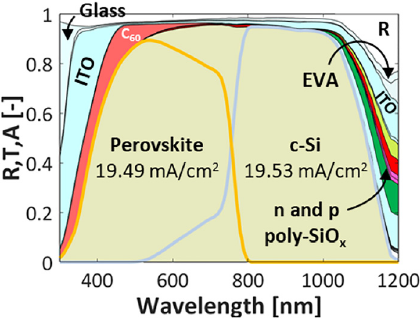
Figure 3: Reflectance and absorptance of 3T encapsulated perovskite/c-Si tandem solar cell (see Figure 1(d)) with top cell and TRJ as in the study by Sahli et al. [8] and a c-Si IBC bottom cell passivated with poly-SiO x CSPCs.